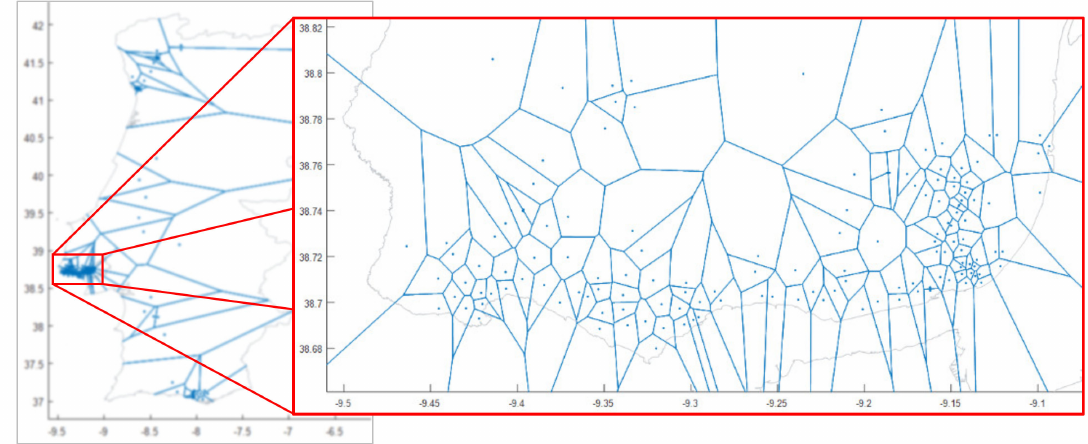
Figure 12. An example of a subject’s only visited Voronoi-cell map with a zoom-in of Lisbon